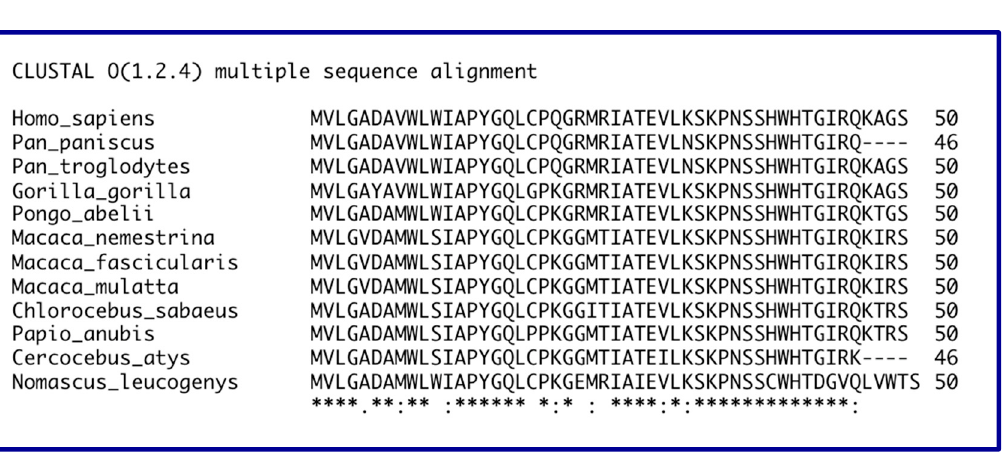
human primates. The GAS5 ortholog in the eleven non-human primates goes by various names including